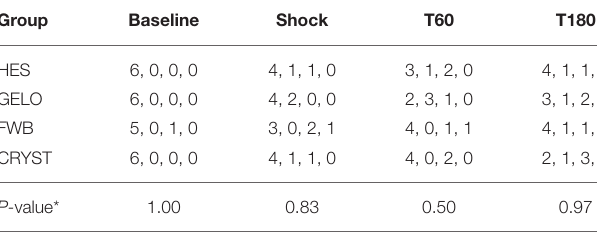
TABLE 3 | Hyperfibrinolysis scores in dogs ( n = 6 per group) with hemorrhagic shock given 20mL kg − 1 of either fresh whole blood (FWB), hydroxyethyl